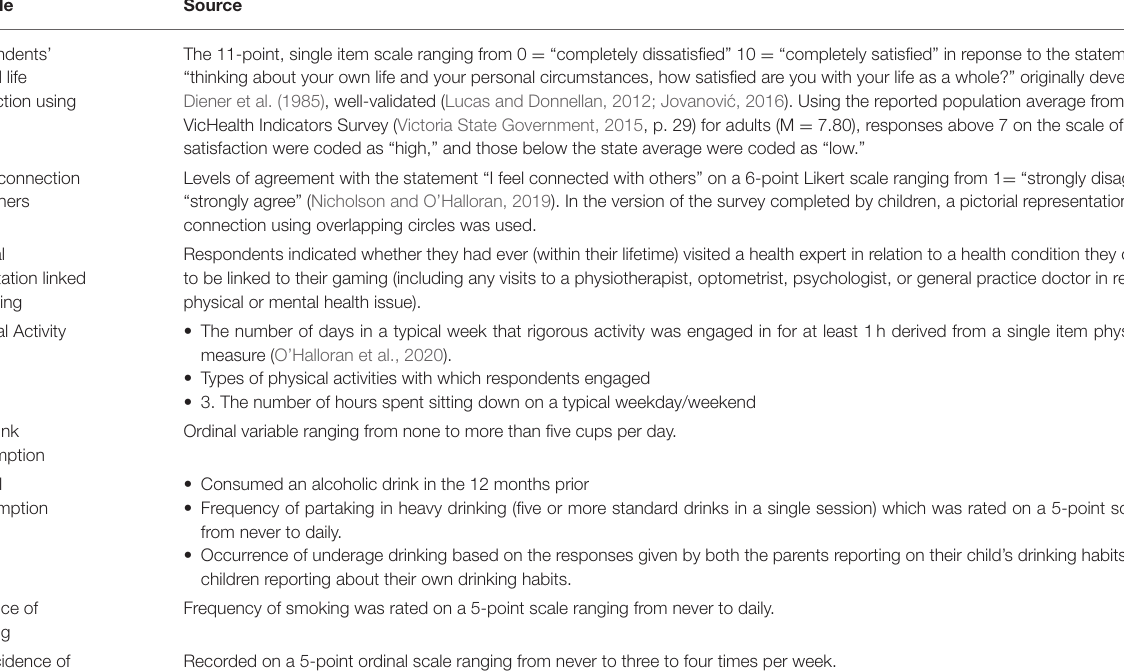
TABLE 1 | Description of key survey measures. Variable